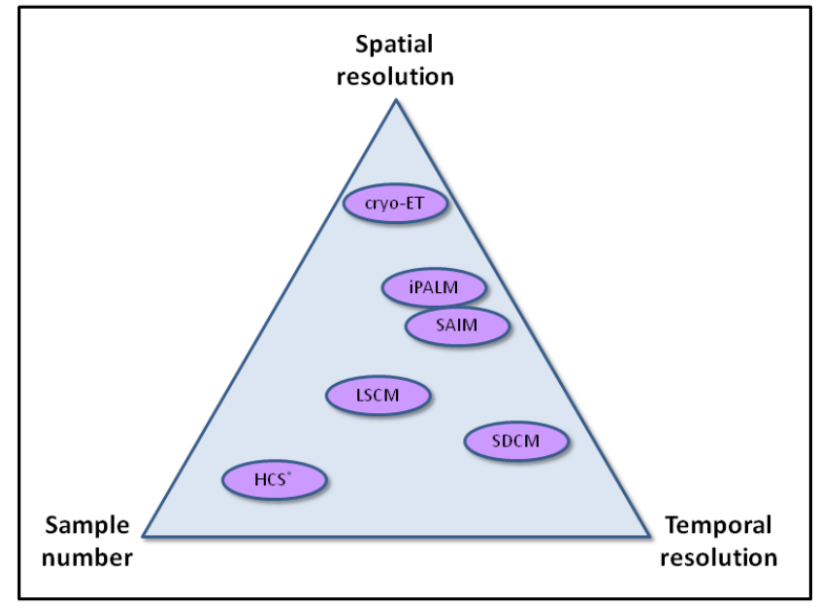
Figure 3. Schematic representation of how various imaging modalities compare in terms of spatial resolution, temporal resolution, and sample number; note that the temporal resolution of HCS is largely determined by the number of samples analyzed in